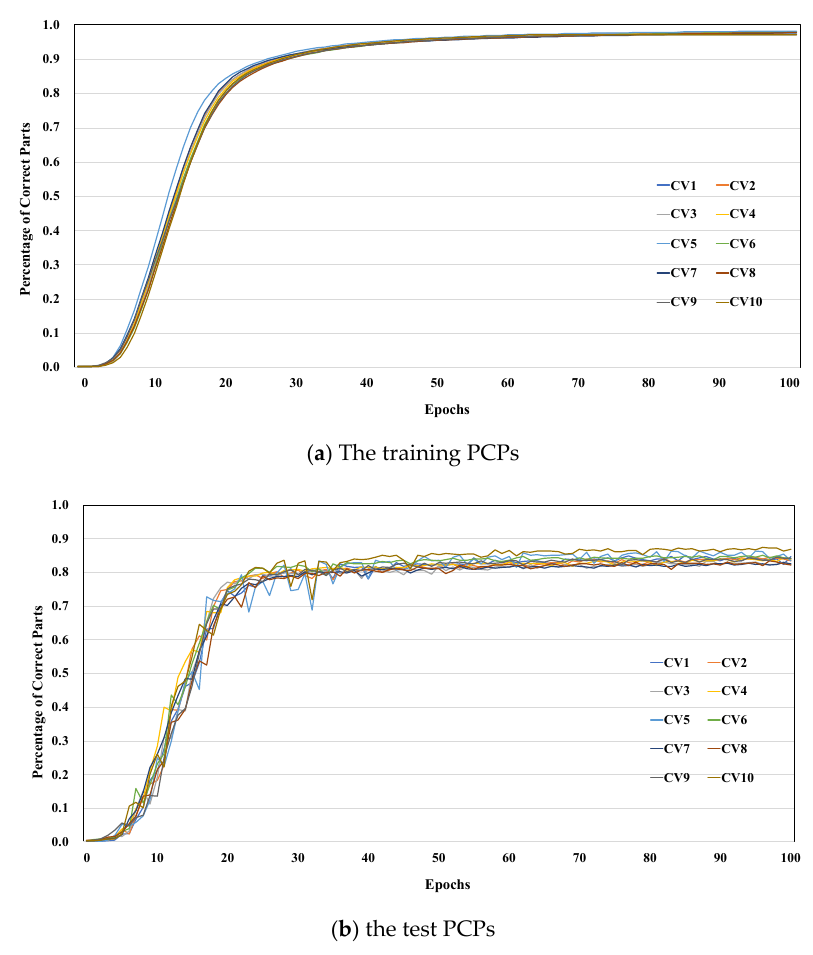
Figure 7. Training results of the proposed DNN model.